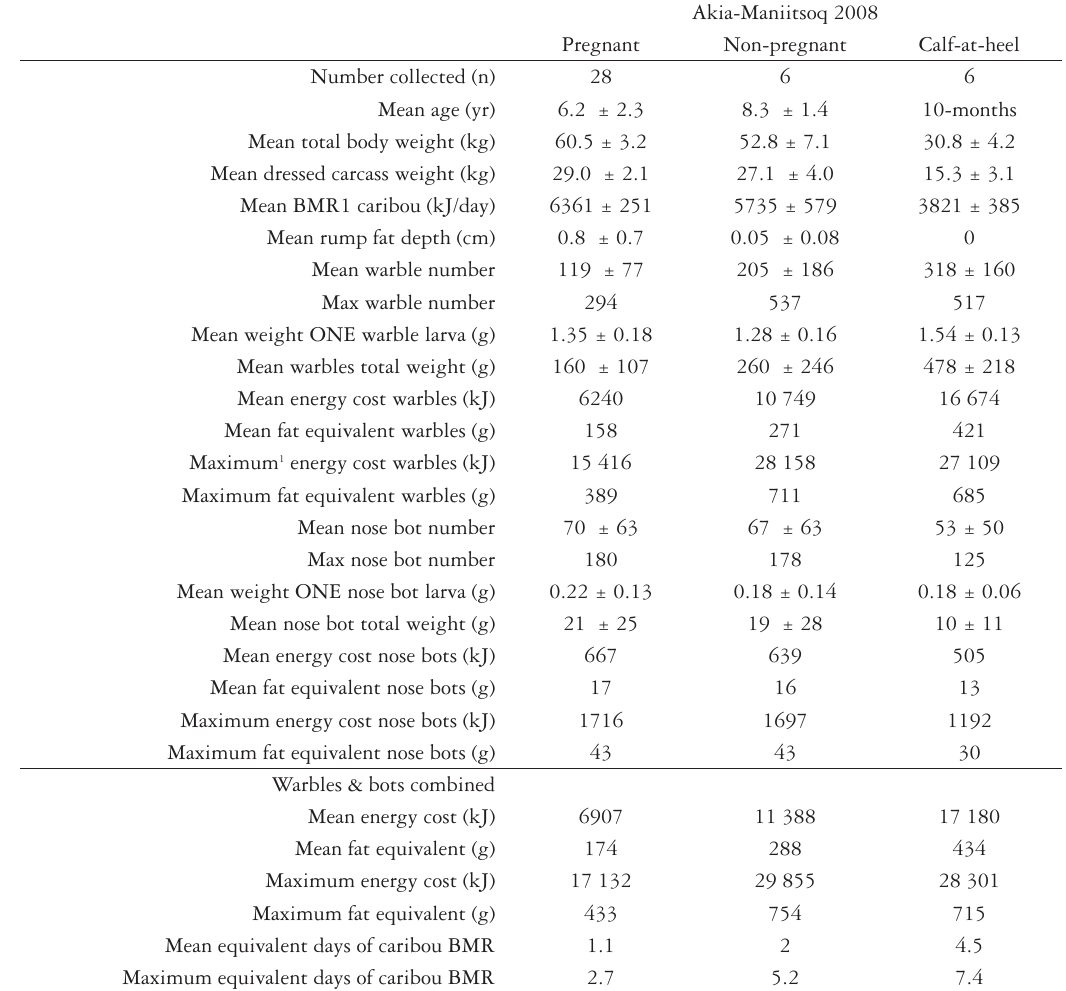
Table 1. Akia-Maniitsoq caribou of West Greenland: data from adult cows (age > 3-years) and calves-at-heel (age 10-months) collected 29 March – 13 April 2008, mean ± SD or maximum. Akia-Maniitsoq